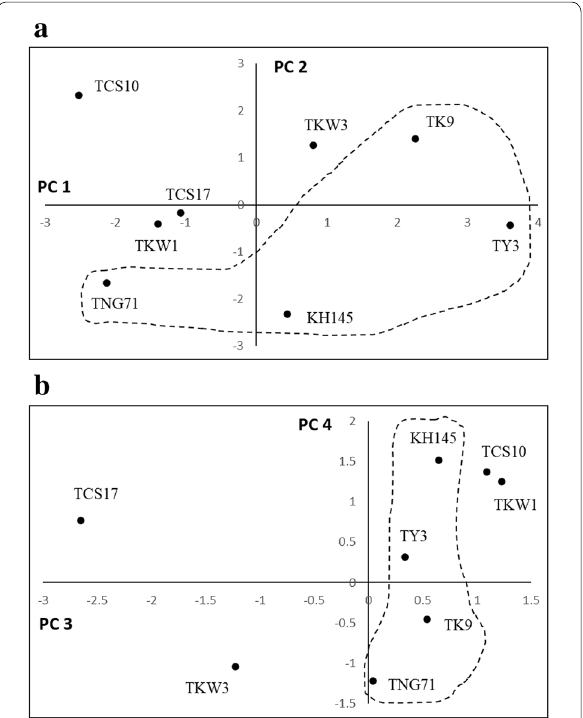
Fig. 5 Biplots for the rice cultivars, TY3, TK9, TNG71, KH145, TKW1, TKW3, TCS10, and TCS17 on the coordinates a PC1 vs. PC2 and b PC3 vs. PC4, respectively. The first four principal components (i.e. PC1, PC2, PC3, and PC4), which were derived from the 12 variants for plant growth, Cd accumulation and physiological indices, explained 85.4% of the cultivars’ variance corresponding to the eigenvalues λ 1 λ 2 2.5, λ 3 1.7, and λ 4 1.3, respectively. The dash line delineates = = = the group of TY3, TK9, TNG71, and